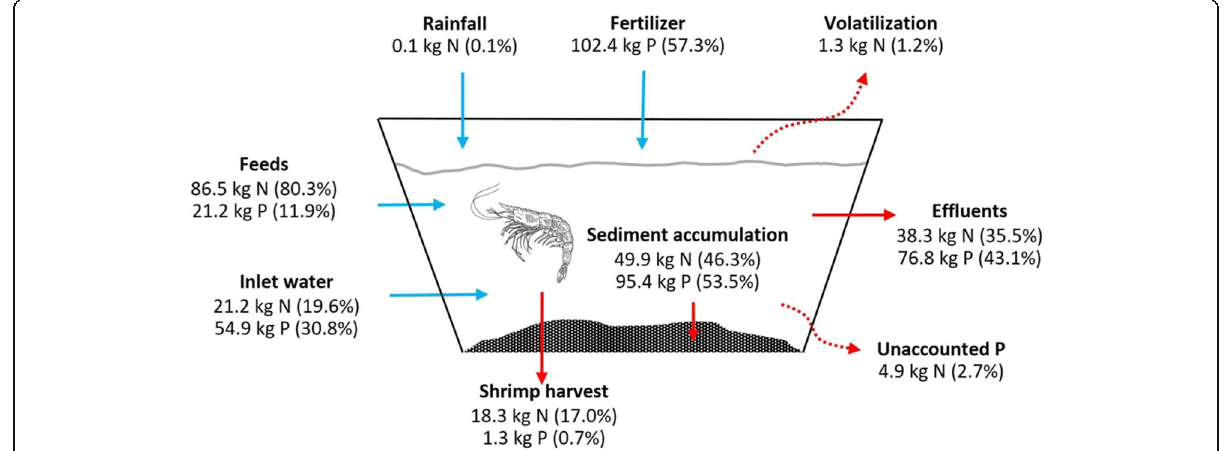
Fig. 5 Nutrient budget in an intensive whiteleg shrimp farm